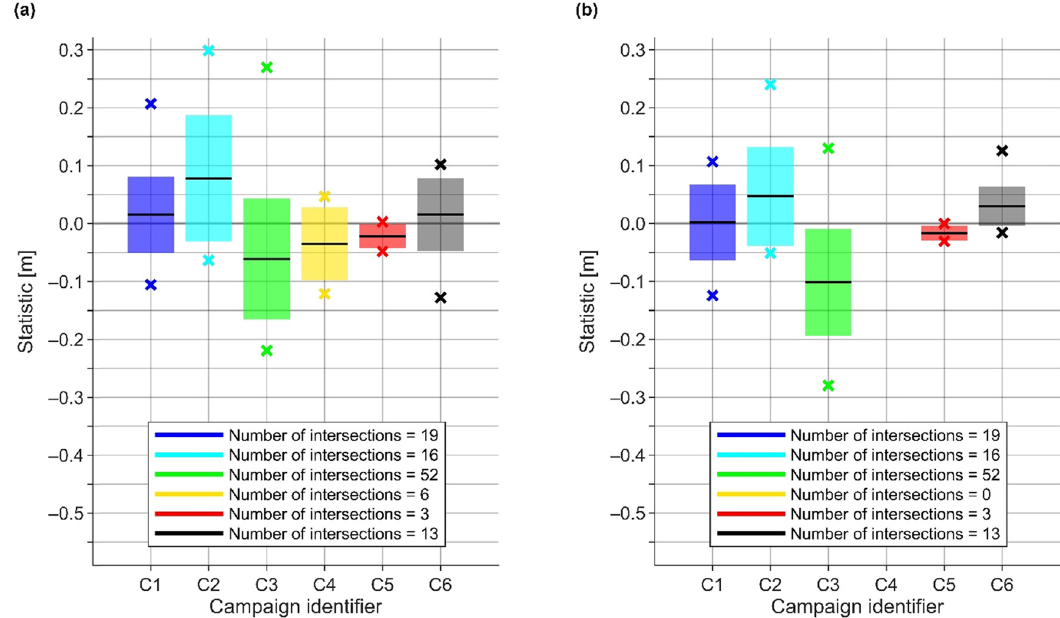
Figure 13: Statistical properties of di ff erences between low - pass fi ltered SSH of antennas A2 ( a ) and A4 ( b ) at campaign - internal inter - sections. The black lines are mean di ff erences, and colored bars denote standard deviation estimates of di ff erences. Crosses denote minimum and maximum di ff